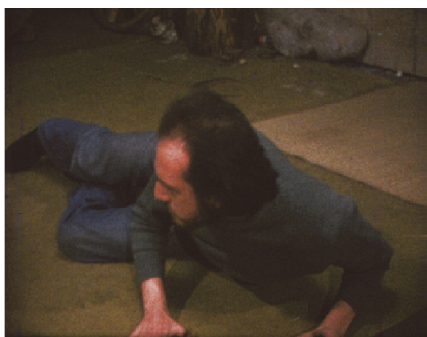
Figure 7: Restored frame in Figure 2 using the proposed algorithm.